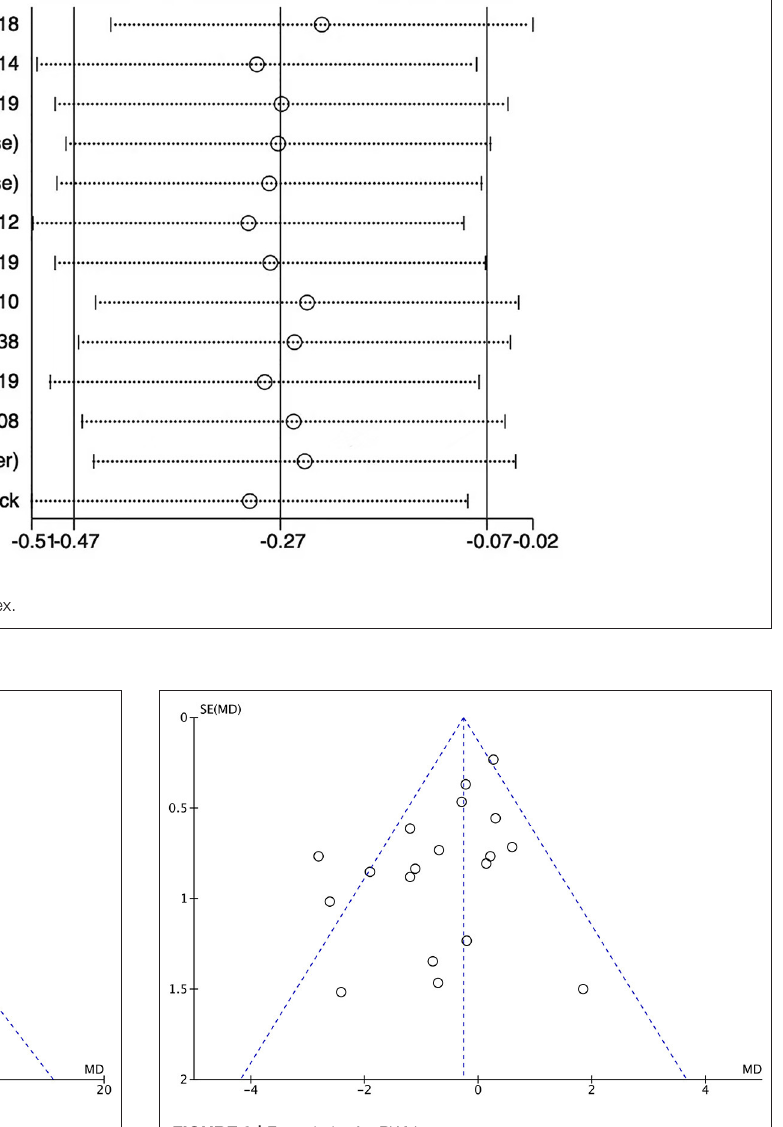
FIGURE 8 | Funnel plot for augmentation index. FIGURE 9 | Funnel plot for